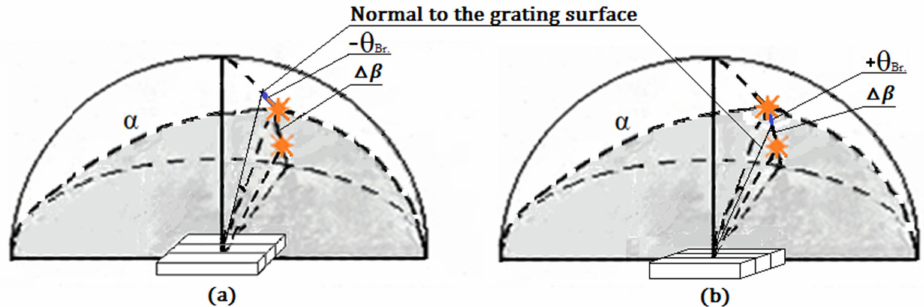
Figure 8. Schemes explaining grating orientation: ( a ) Position 1 and ( b ) Position